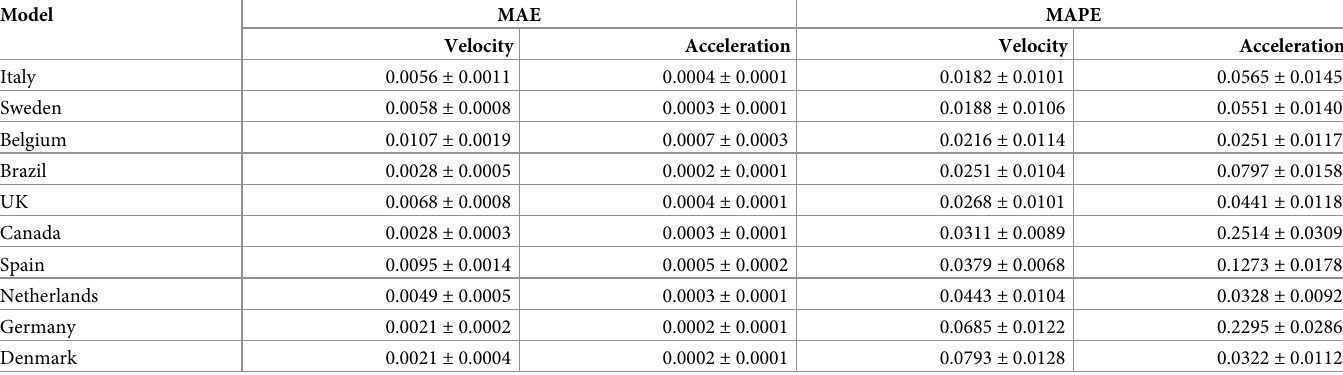
Table 5. Model effectiveness at June 5th 2020, for some countries. The prediction error is given both in terms of the mean absolute error (MAE) and mean absolute per- cent error (MAPE). Error is calculated on a daily-basis and then it is averaged. Standard deviation is also shown. Model